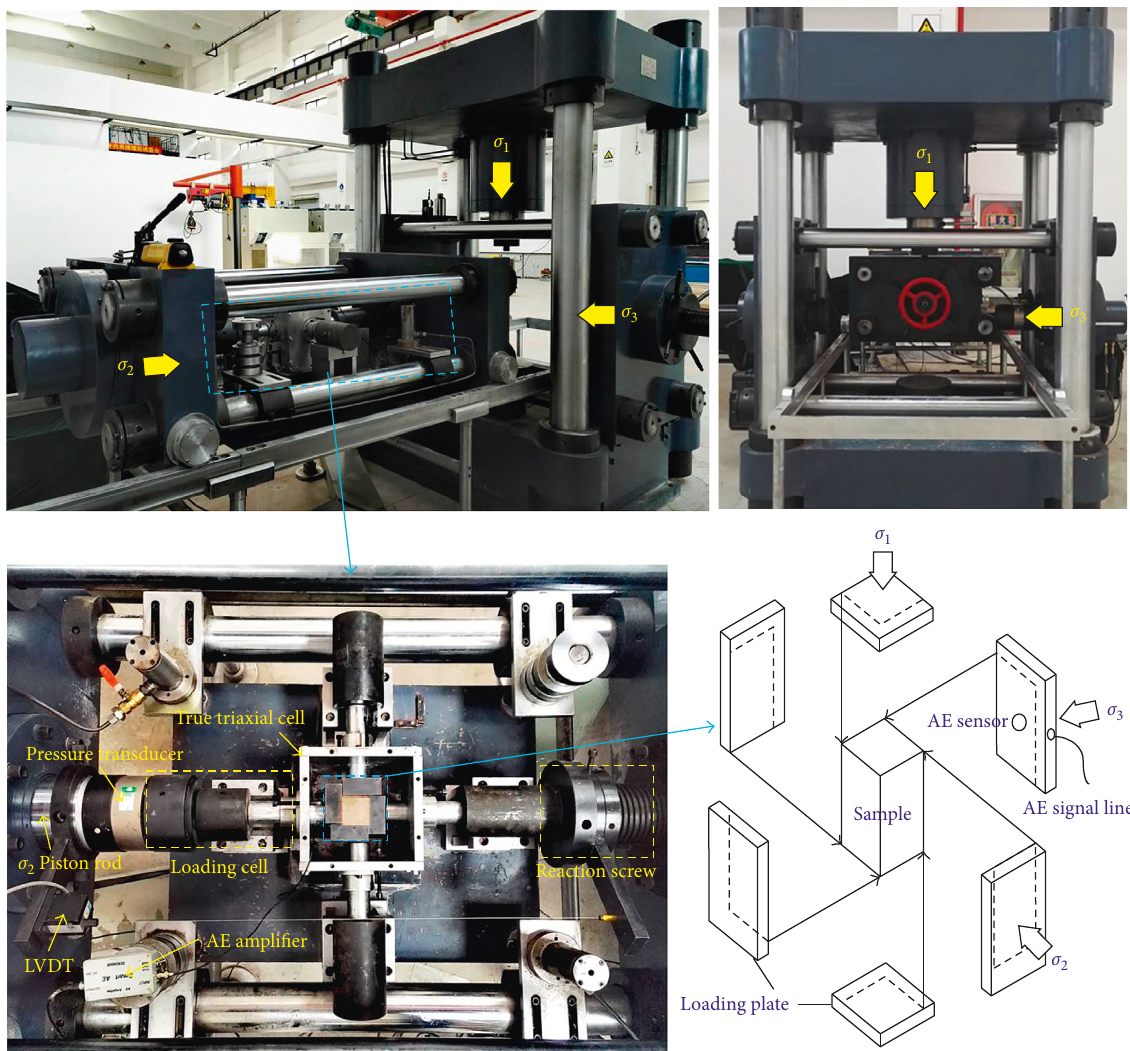
Figure 1: True triaxial compression test